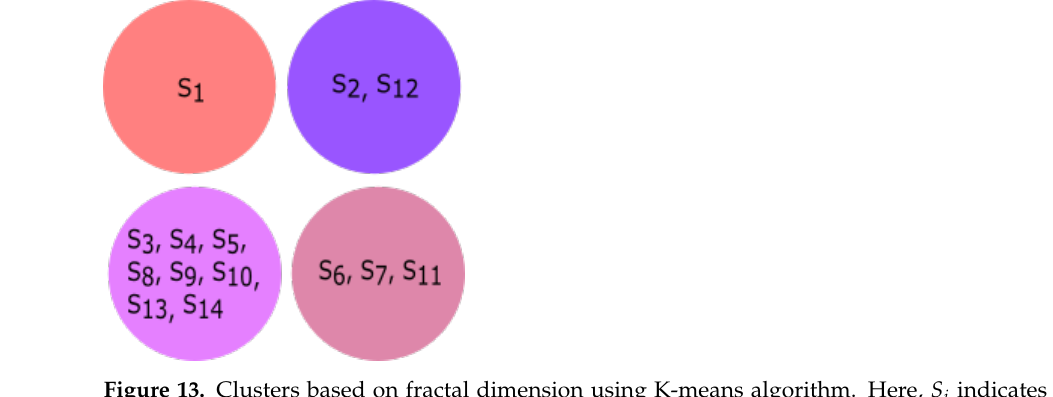
Figure 13. Clusters based on fractal dimension using K-means algorithm. Here, S i indicates the species name as specified in Table 1.